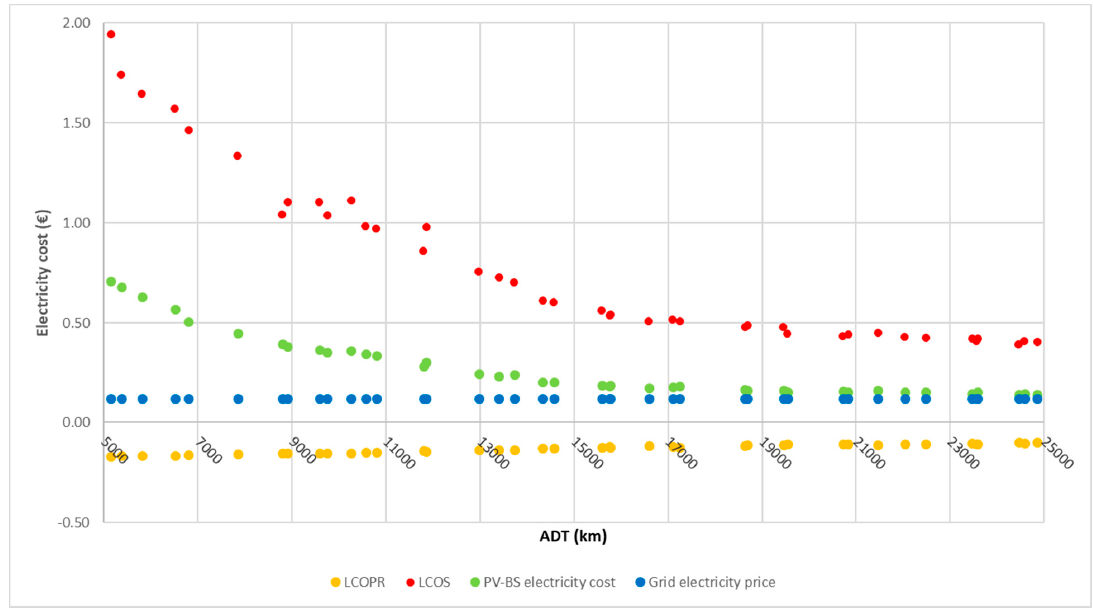
Figure 9. LCOPR, LCOS, and PV–BS electricity cost in Scenario 2 with solar forecast-based strategy.